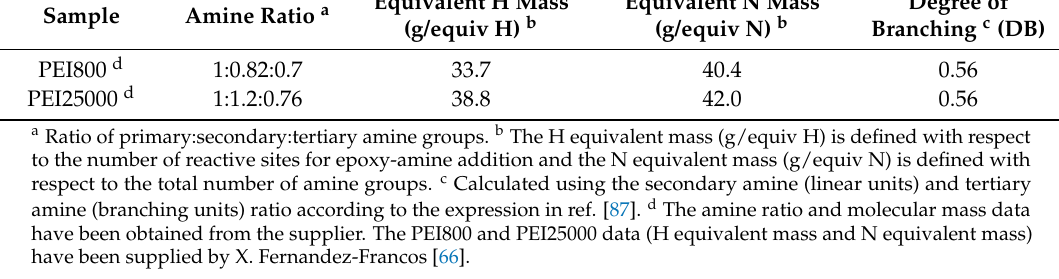
Table 6. Characteristics of the HBPEI samples.